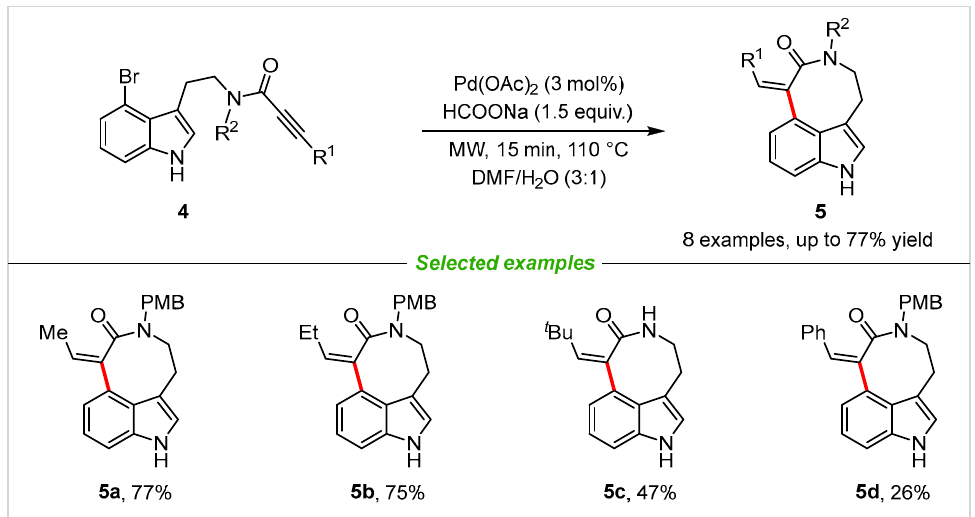
Scheme 3. Synthesis of 3,4-fused tricyclic indoles through palladium-catalyzed